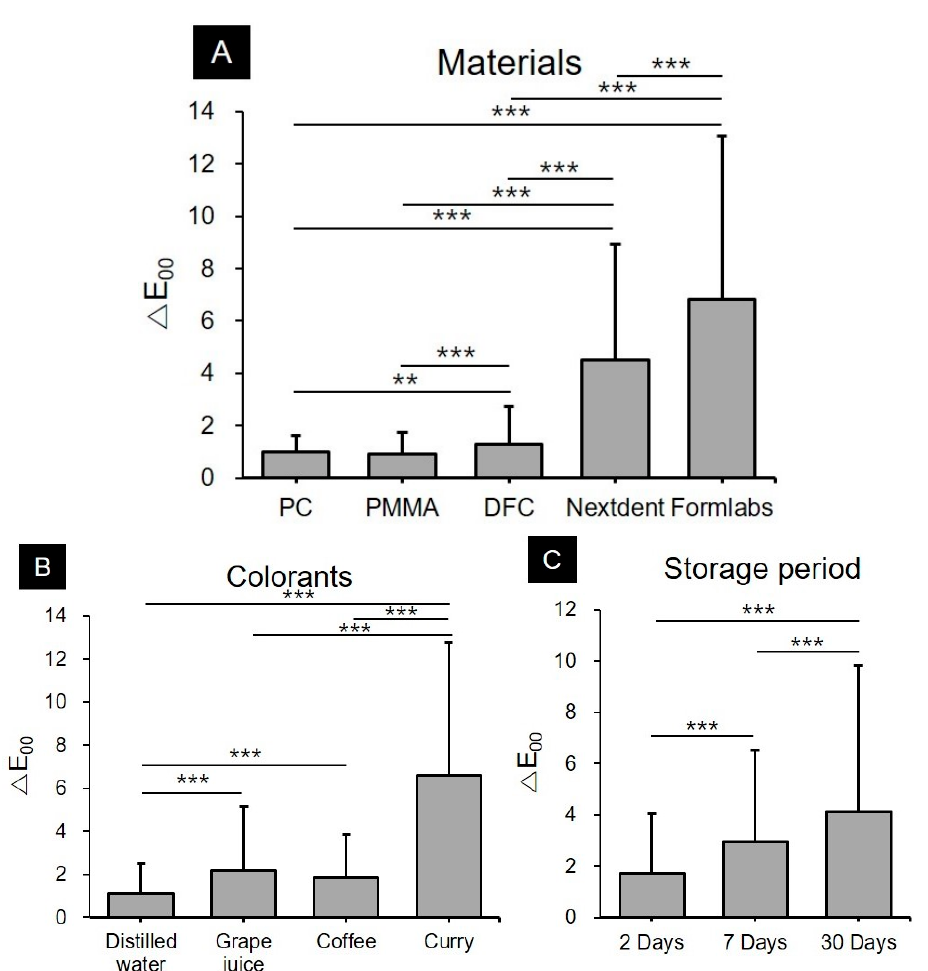
Figure 2. Results of the three-way ANOVA analysis of the changes in color tones according to the ( A ) materials used, ( B ) colorants, and ( C ) storage periods used in the study. The average was cumulative over the set of all other conditions. It is observed that color stability of 3D printing resins is low, and the changes in the color tone are significantly different depending on the type of colorant used and the storage period (mean + standard deviation). The double (**) asterisk represents a p -value ≤ 0.01 and the triple (***) asterisk represents a p -value ≤ 0.001.